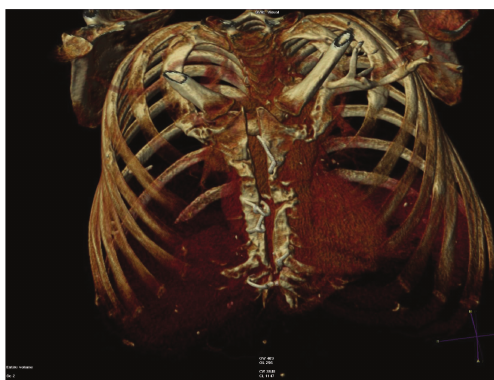
[5], aortic injury [6], hemoptysis [7], and pulmonary valve endocarditis [8]. Right Ventricular laceration due to sternal wire migration is associated with mortality of up to